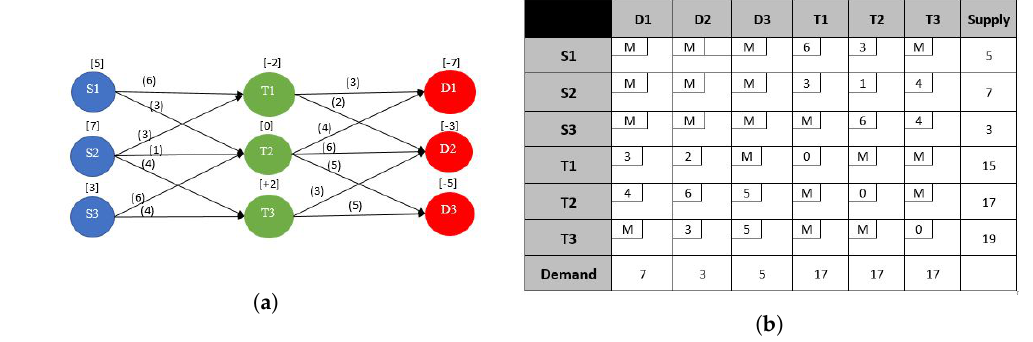
Figure 6. An illustrative example of a simple transportation problem. ( a ) NFP model of a transshipment problem; ( b ) Tableau of a transshipment